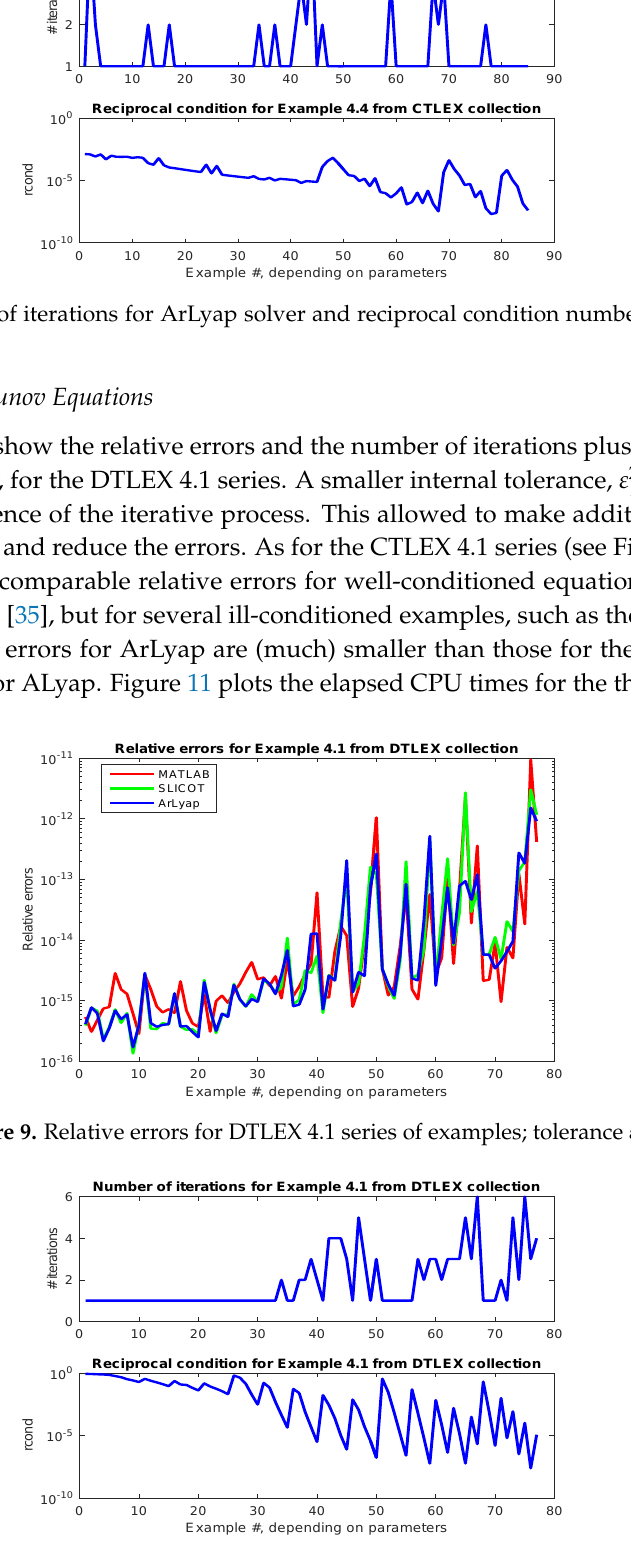
Figure 10. Number of iterations for ArLyap solver and reciprocal condition numbers for DTLEX 4.1 series of examples; tolerance ε 2 M